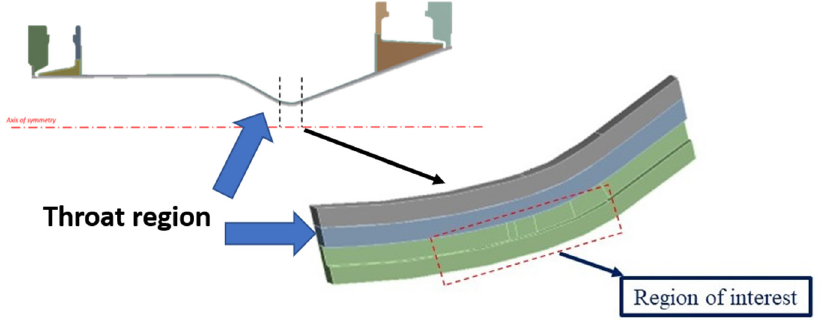
Figure 4. Regions of interest numerically analyzed.